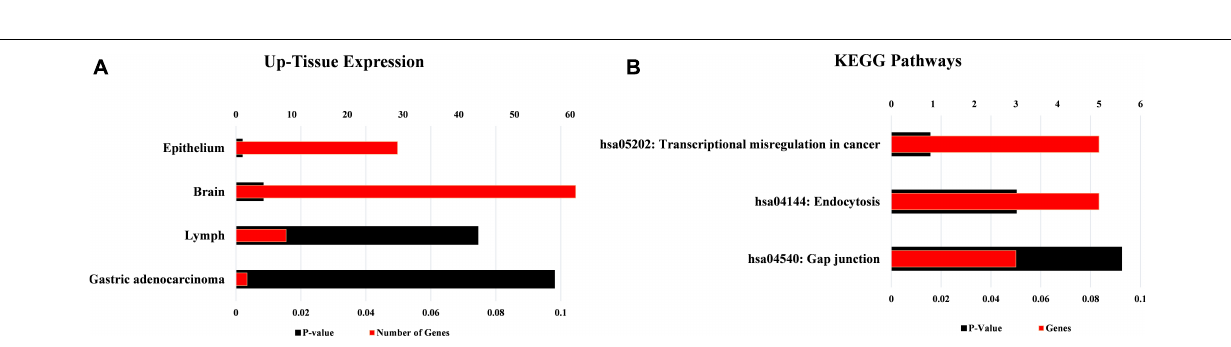
FIGURE 7 | Functional annotations of target mRNAs. (A) Up-tissue expression of target mRNAs regulated by these both circRNAs. (B) KEGG pathway analysis of these targets’